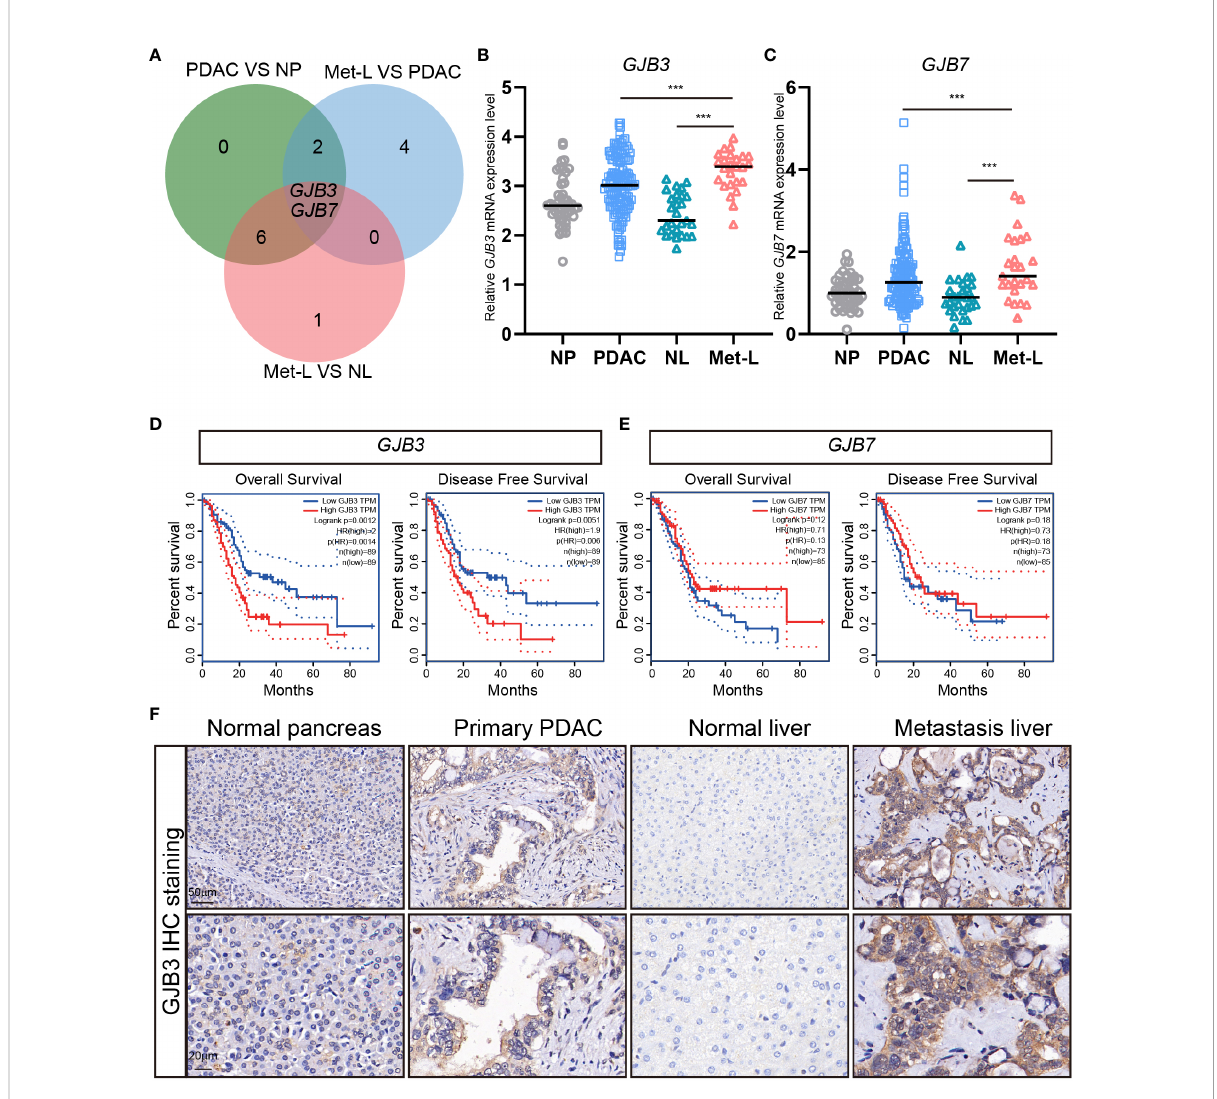
FIGURE 1 The expression of GJB3 in PDAC liver metastasis. (A) . The Veen diagram of connexins genes that increased in primary PDAC and liver metastasis of PDAC. NP, normal pancreas; PDAC, primary pancreatic cancer; NL, normal liver; Met-L, liver metastasis of pancreatic cancer. (B, C) . The normalized mRNA expression of GJB3 and GJB7 in normal pancreas (n = 46), primary pancreatic cancer (n = 145), normal liver (n = 27) and liver metastasis (n = 25) of pancreatic cancer. (D, E) The overall survival and disease-free survival of GJB3 and GJB7 in the TCGA PDAC cohort. (F) . The IHC staining of GJB3 in normal pancreas, primary pancreatic cancer, normal liver and liver metastasis of pancreatic cancer. Scale bar is 50 m m for the up panel and 20 m m for the down panel. Data presented as mean±standard deviation.